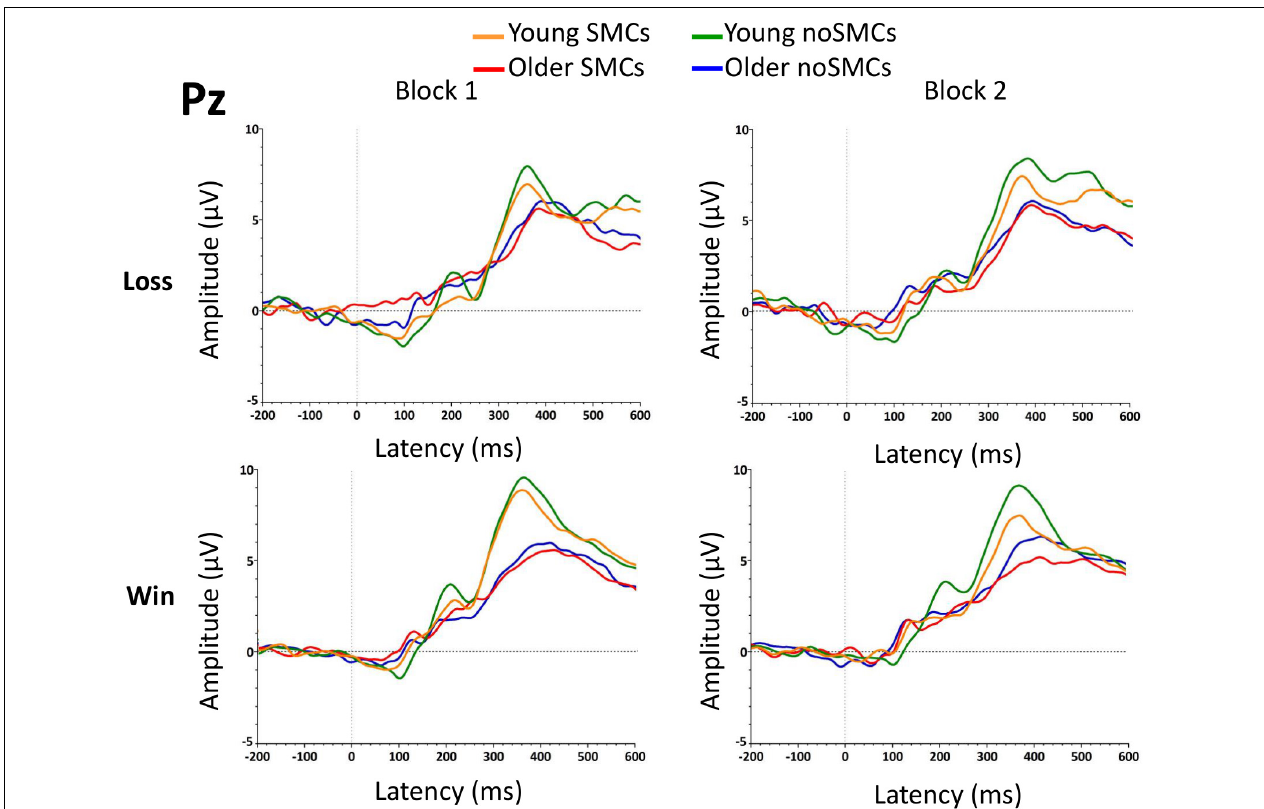
FIGURE 5 | Grand averages of the P3 component at the Pz electrode for the two